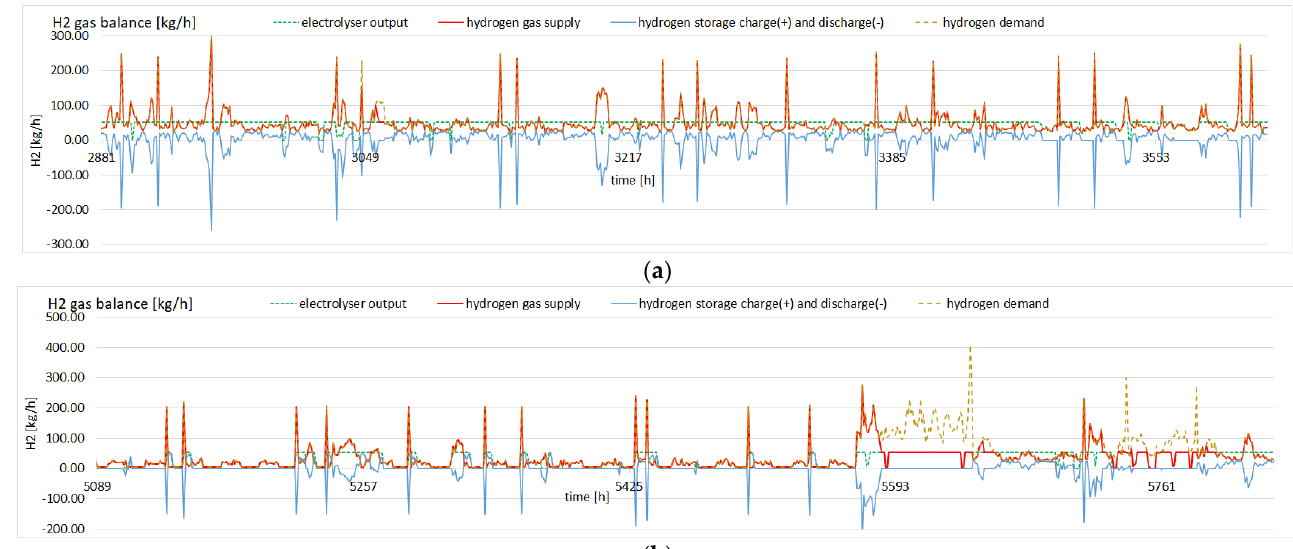
Figure 4. Case electric energy flows (simulation results). ( a ) May; ( b ) August.